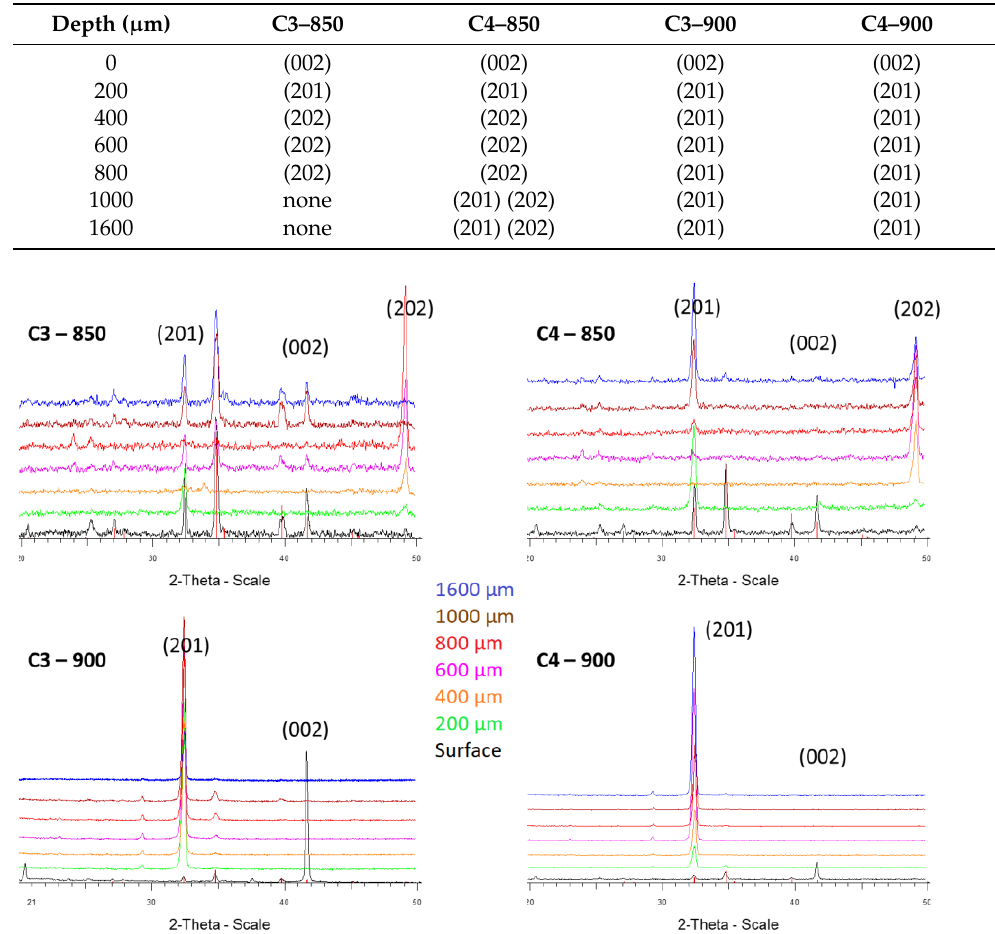
Table 6. Summary of the STS diffraction peaks showing a stronger relative intensity with respect to the reference file PDF 00-39-0228 [30].